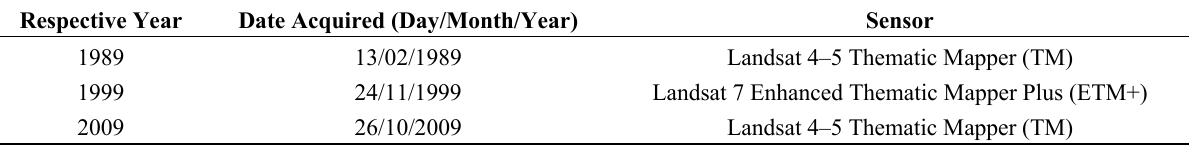
Table 1. Details of Landsat satellite images. Source: US Geological Survey, 2012.